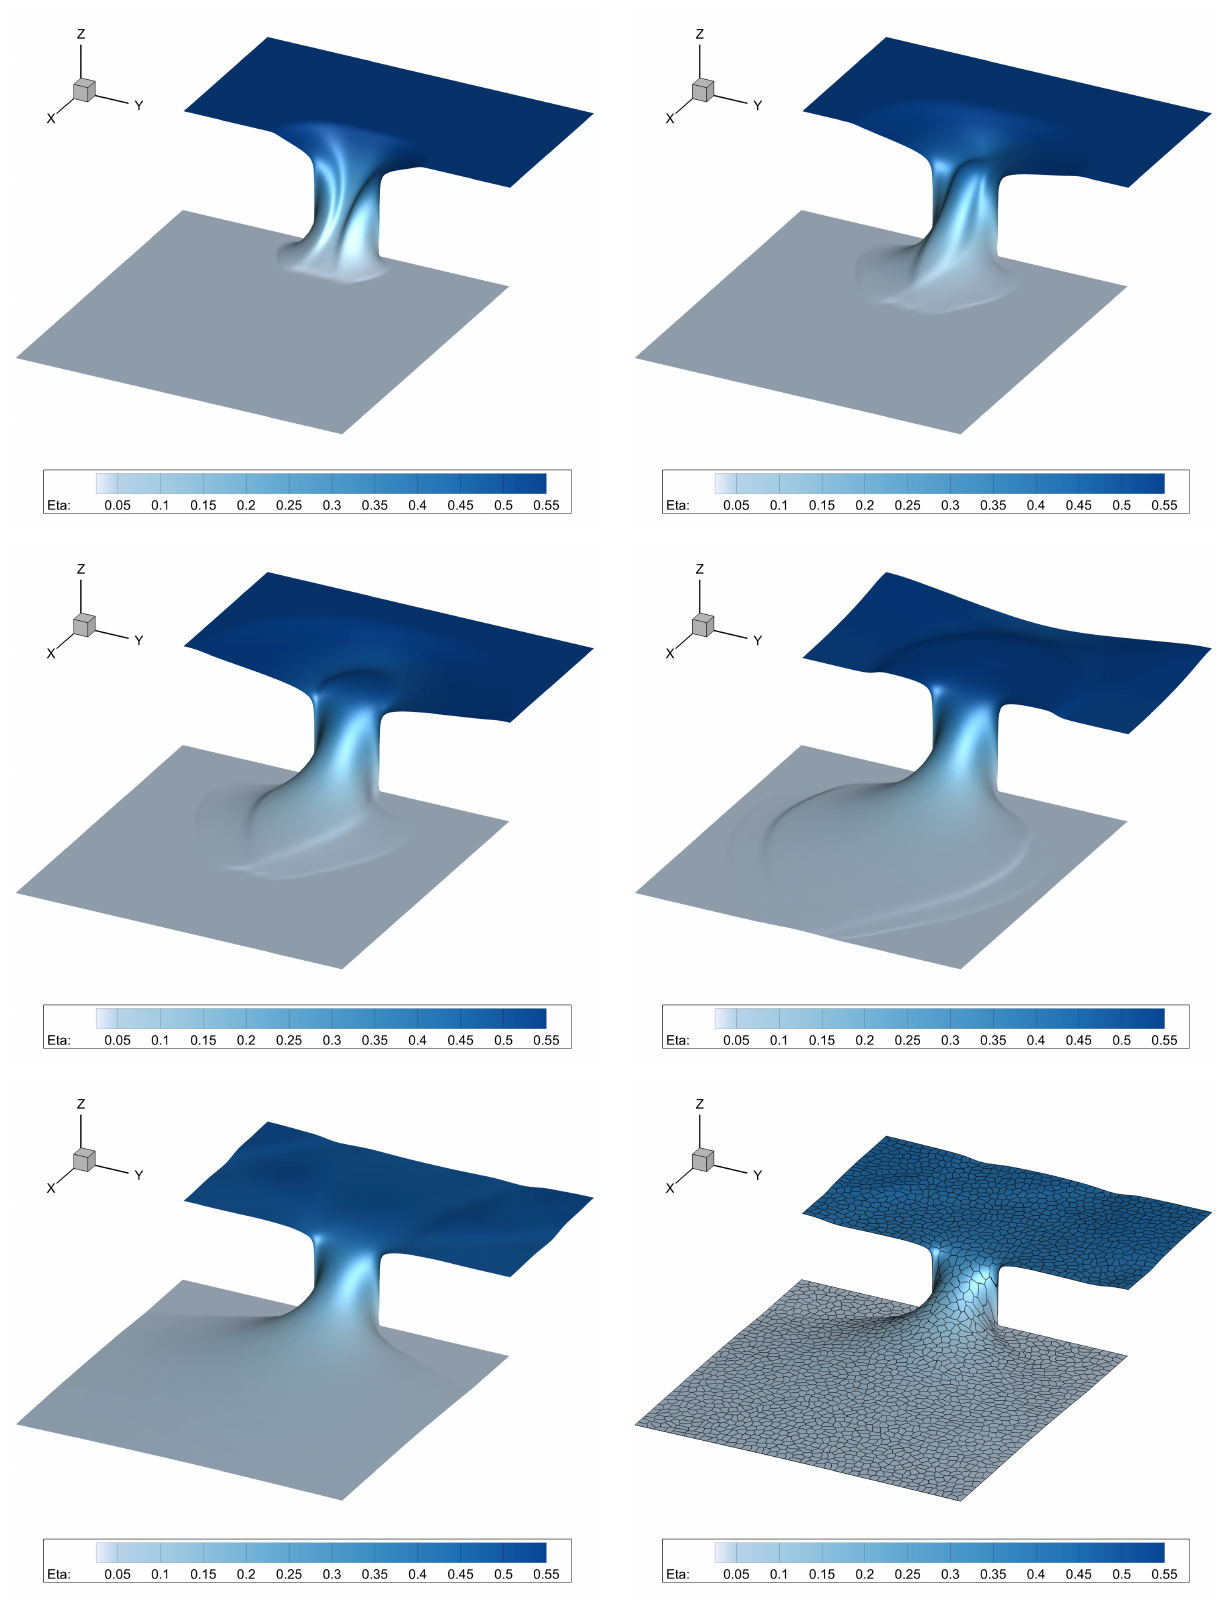
0.1,0.2,0.3,0.5,1.0,2.0 , from top ∈ { }